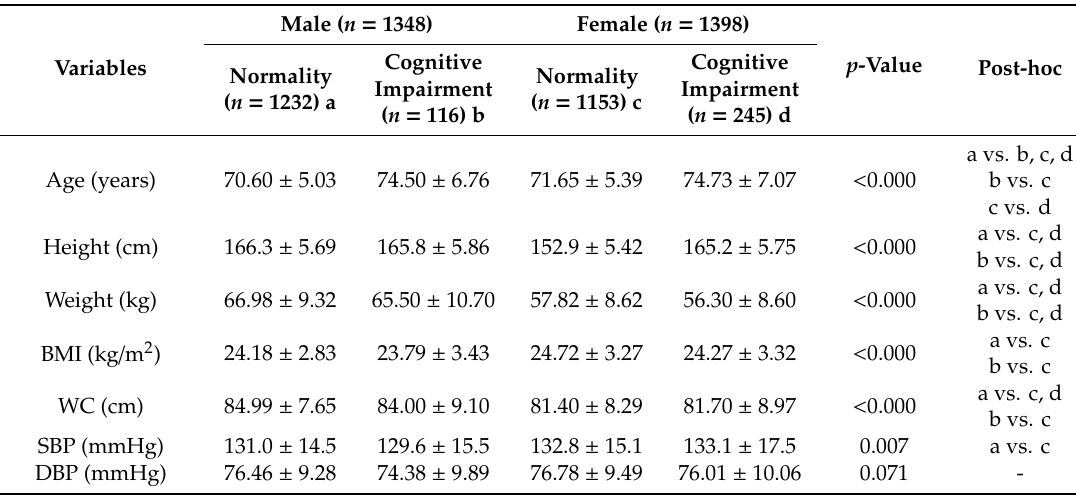
Table 1. The characteristics of the